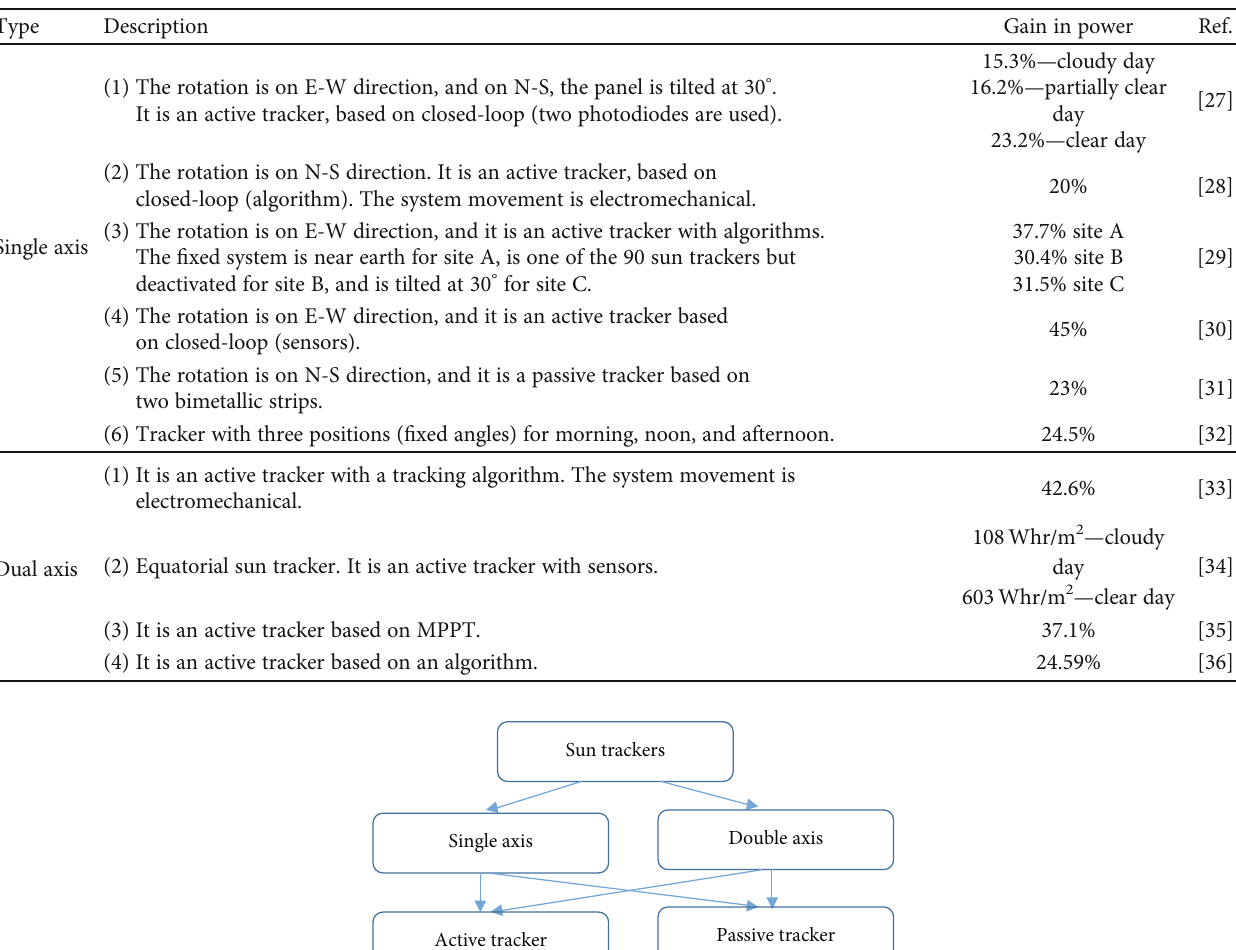
Table 2: Sun tracker types and gain.